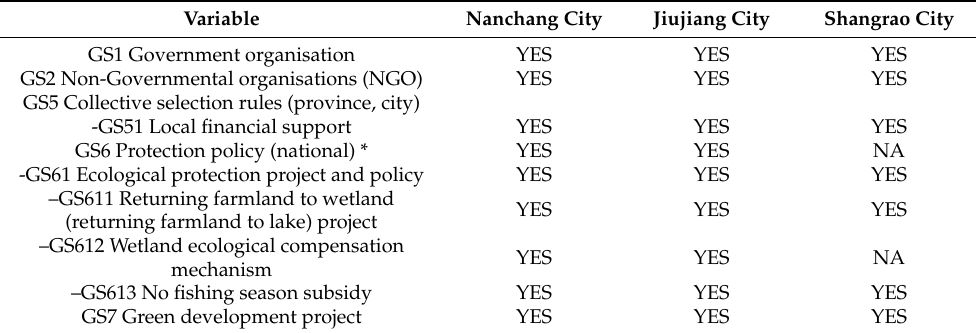
Table 5. Comparison of Poyang Lake wetland governance system